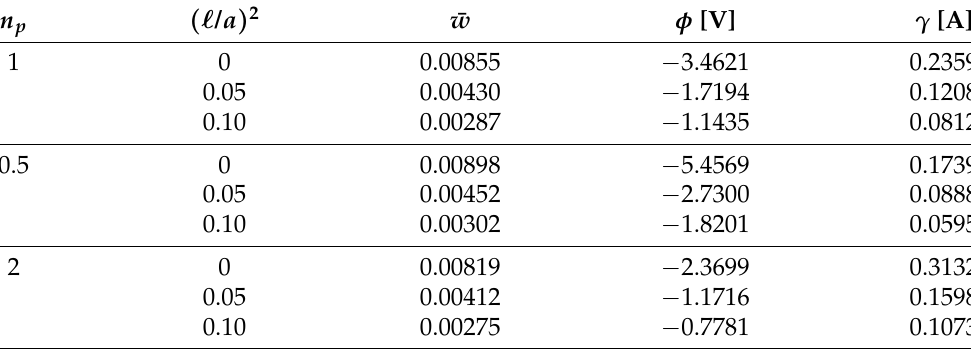
Table 3. Displacement ¯ w , electric and magnetic potential φ and γ , of a square nanoplate in central point ( a /2, b /2 ) for different values of nonlocal parameter ( (cid:96) / a ) 2 and n p . (SDL; q = 0 N/m 2